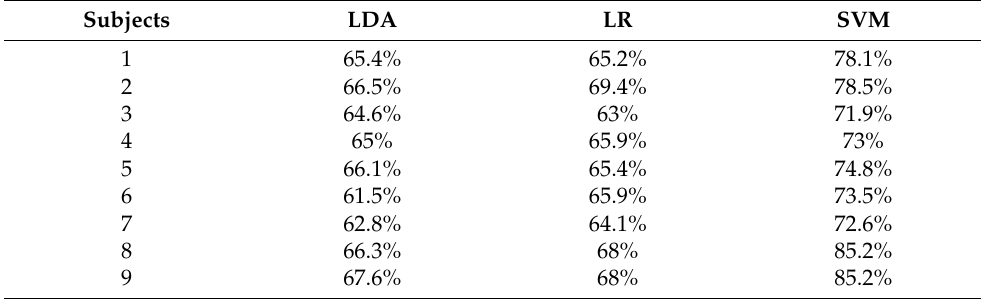
Table 4. Subject-wise classification accuracies of all subjects (%) were obtained by extracting features (i.e., SM. SP, SV, and SK) of HbO signals and classification using SVM, LDA, and LR of the walking and resting states (binary classification) of 9